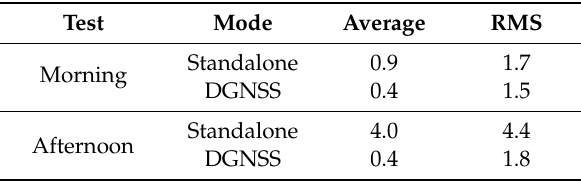
Table 3. Smartphone performance in the morning and in the